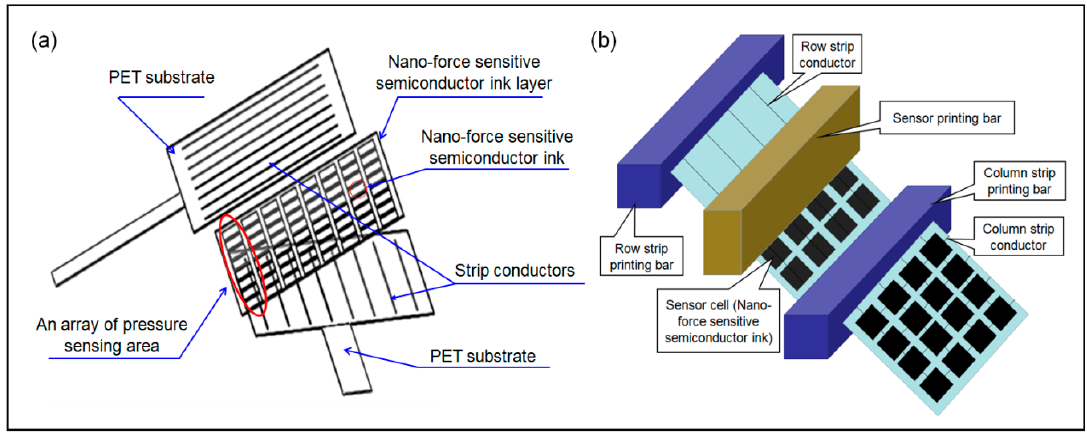
Figure 2. The matrix soft sensor. ( a ) The structure of the soft sensor; ( b ) The fabrication of the soft sensor.